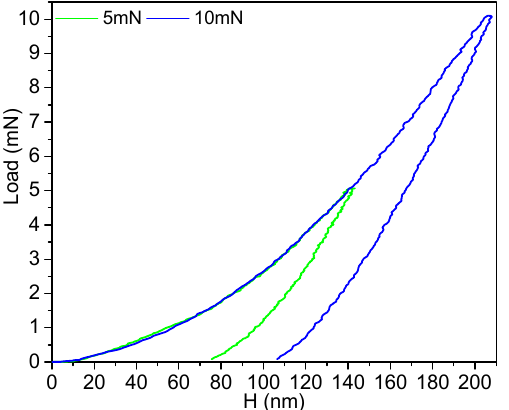
Figure 3. Load and unload curve of nanoindentation test of TaZrN on Si substrate.